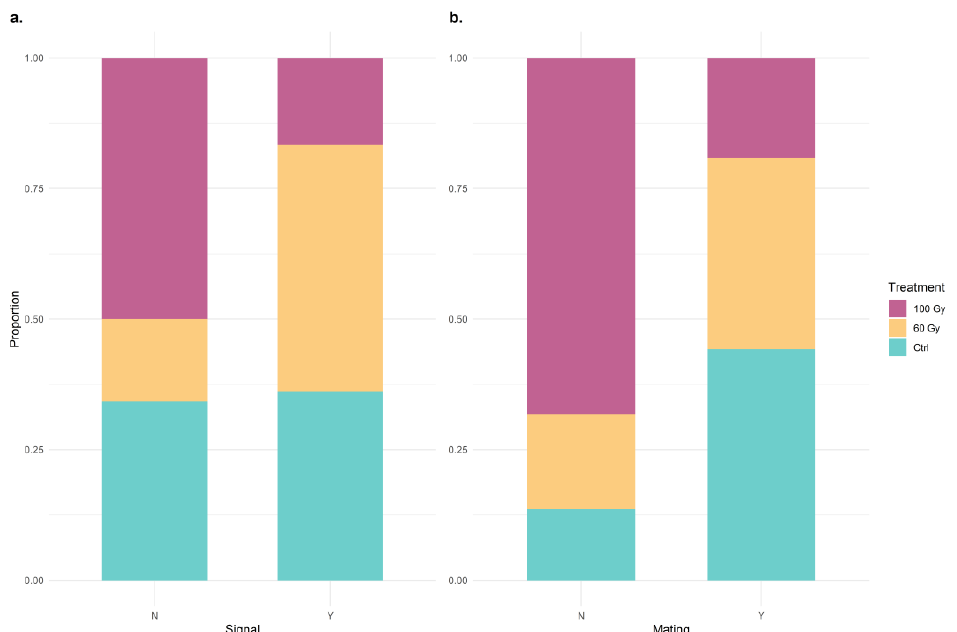
Figure 4. One hundred percent stacked column chart of the effect of different radiation grades ( a ) on the occurrence of signals during the mount phase and ( b ) on mating success following mount phase for each treatment. “N” stands for No, and “Y” stands for Yes. Only the individuals that have reached the mount phase were considered for this